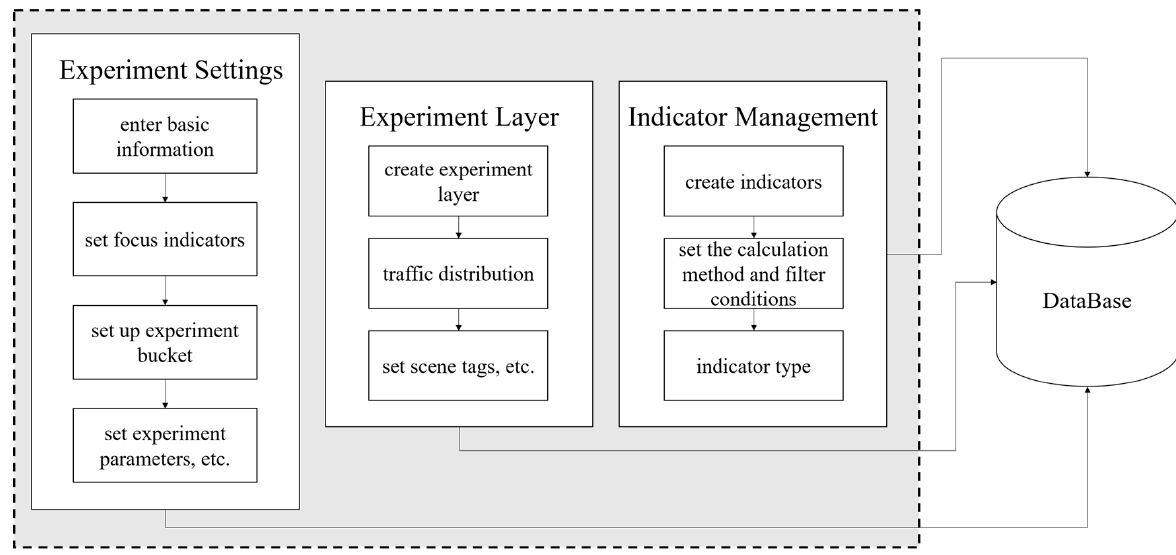
Figure 8. Experiment-management-related information.